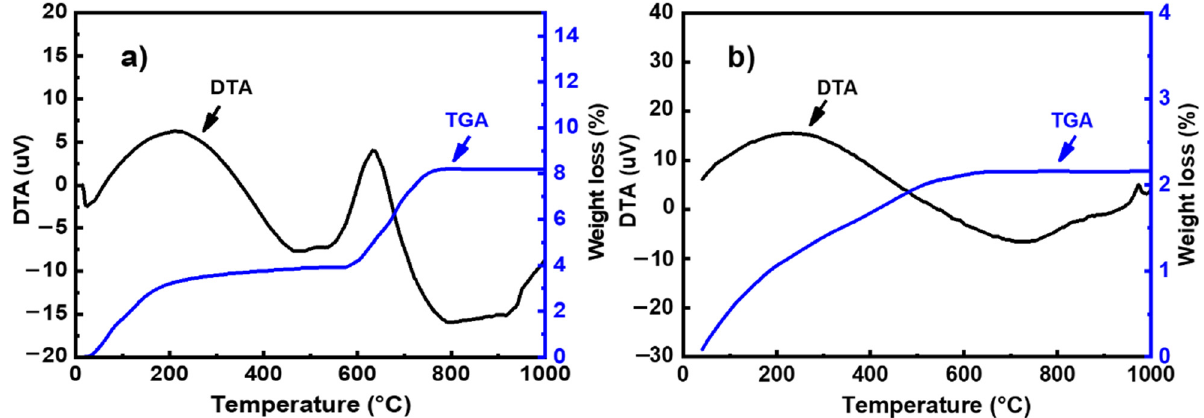
Figure 2. TG–DTA curves for ( a ) metakaolin and ( b ) fly ash.